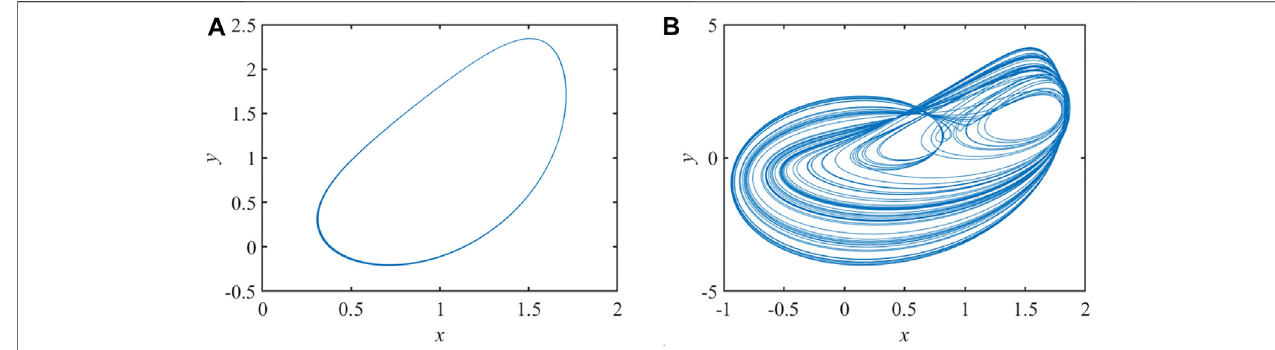
FIGURE 7 | Phase diagram of the system, (A) d = 7.0, (B) d = 19.0.